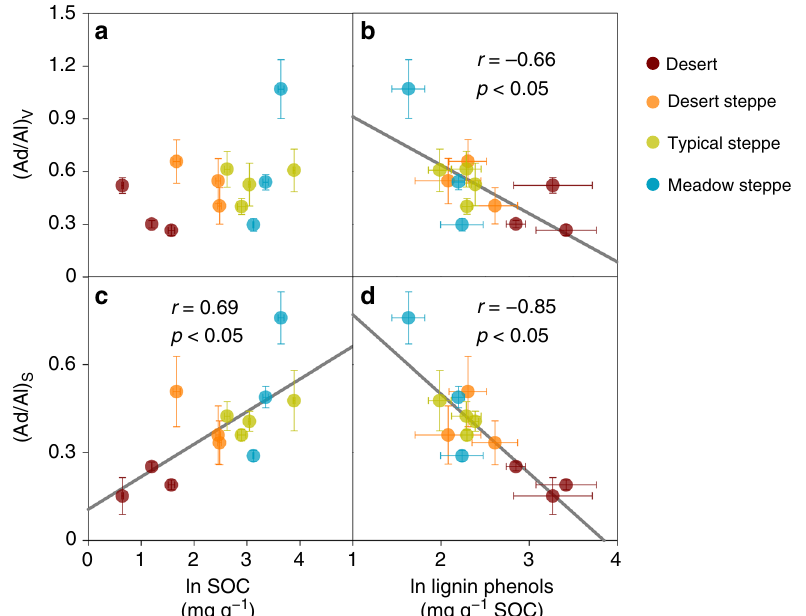
Fig. 4 Variations of lignin acid-to-aldehyde (Ad/Al) ratios in the Mongolian grassland soils. Pearson correlations of the Ad/Al ratios for vanillyl (V) and syringyl (S) phenols with soil organic carbon (SOC; a , c ) and lignin phenol concentrations ( b , d ). Error bars represent s.e.m. for three site replicates. Black lines indicate linear regressions ( p < 0.05; n =